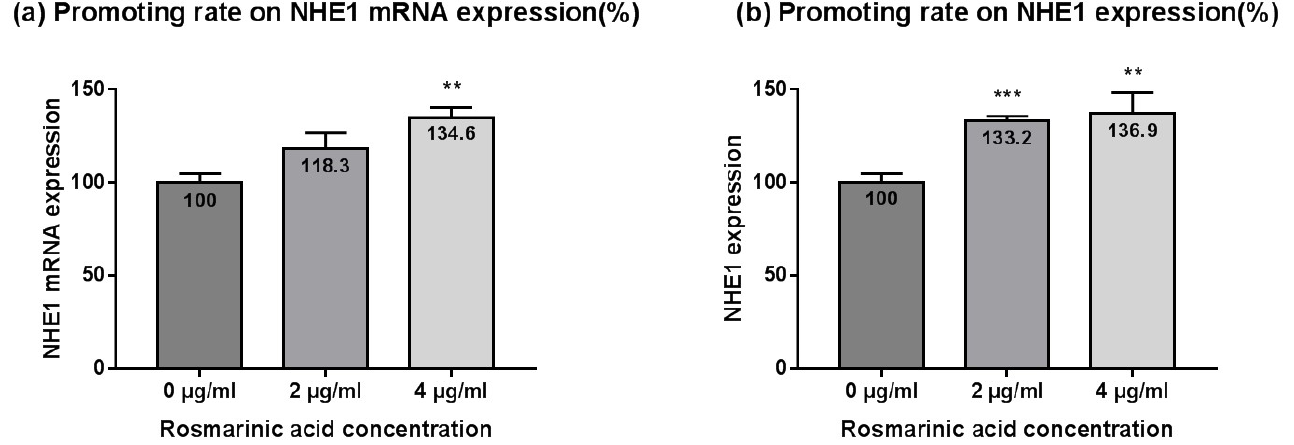
Figure 2. Promoting effects of rosmarinic acid on NHE1 expression. Rosmarinic acid ‐ containing solution increased expression levels of NHE1 mRNA ( a ) and NHE1 ( b ), compared to the control. Data are presented as the mean ± SD ( n = 3). NHE1, sodium proton exchanger 1. Student’s t ‐ test p ‐ values indicate statistical significance (** p < 0.01, and *** p < 0.001).